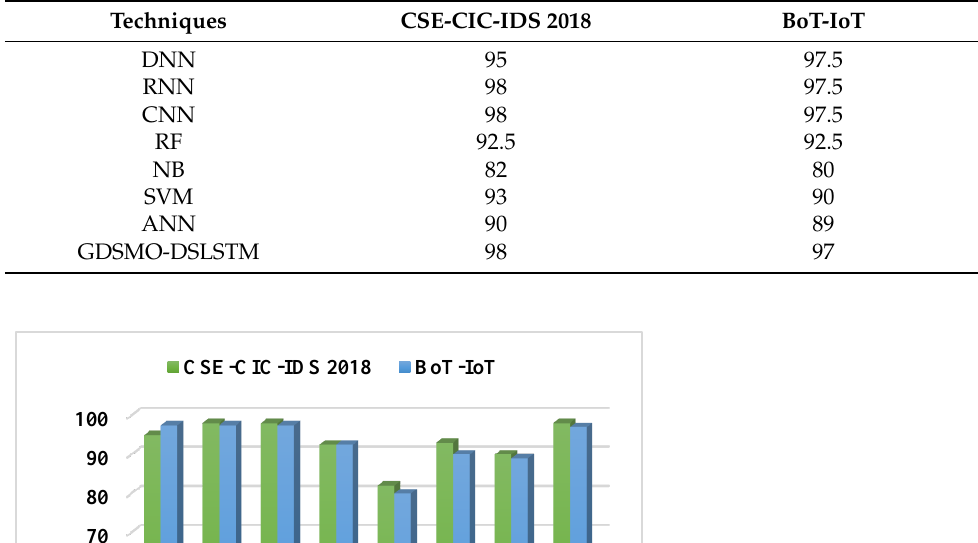
on detection rate. detection rate.